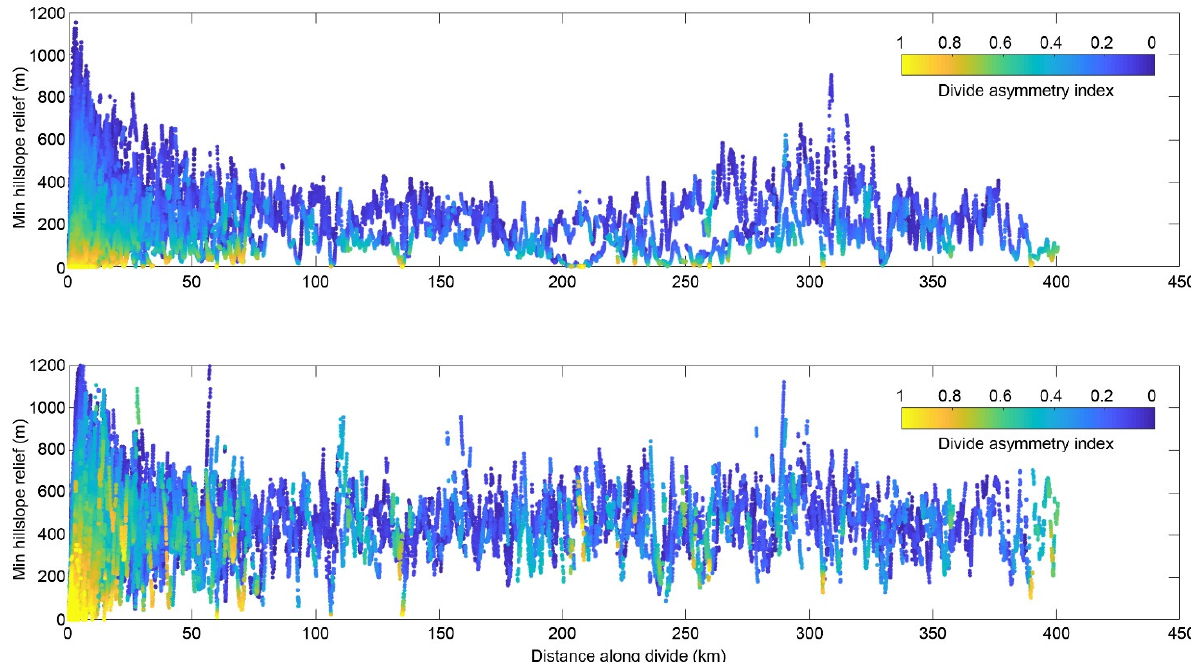
Figure 7. Minimum flow distance along the divide network of the Zengqu River catchment. Colors denote the divide asymmetry index (DAI).